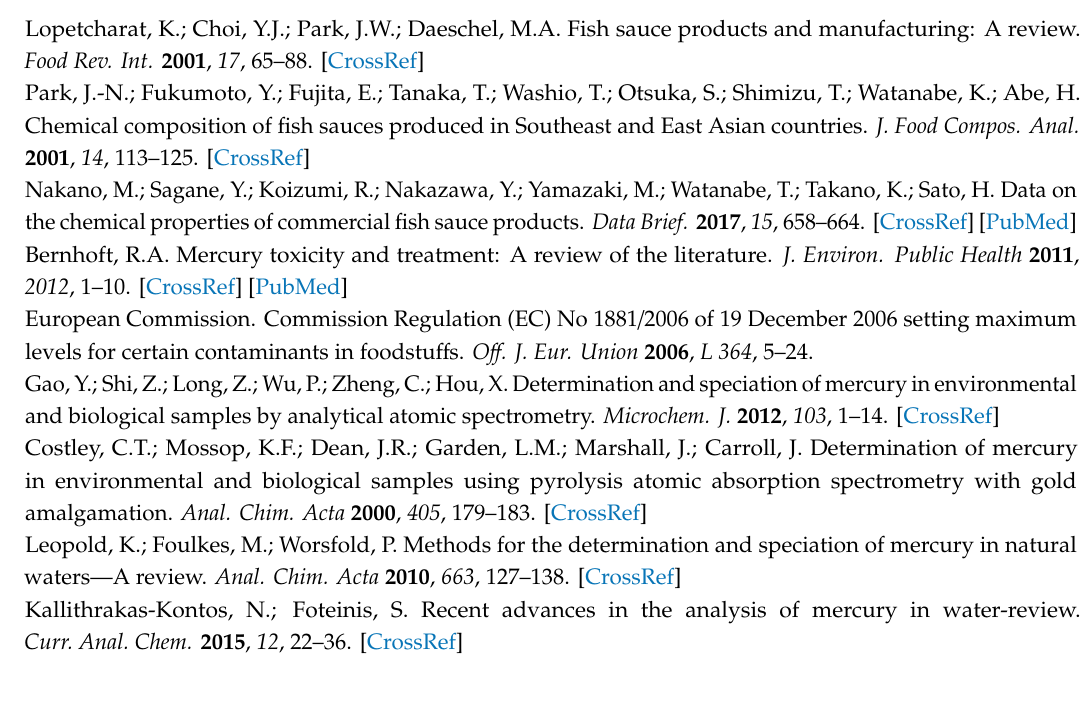
Figure S1: Measured mass of mercury in the binding gels immersed in Hg model solution for di ff erent thicknesses of di ff usive